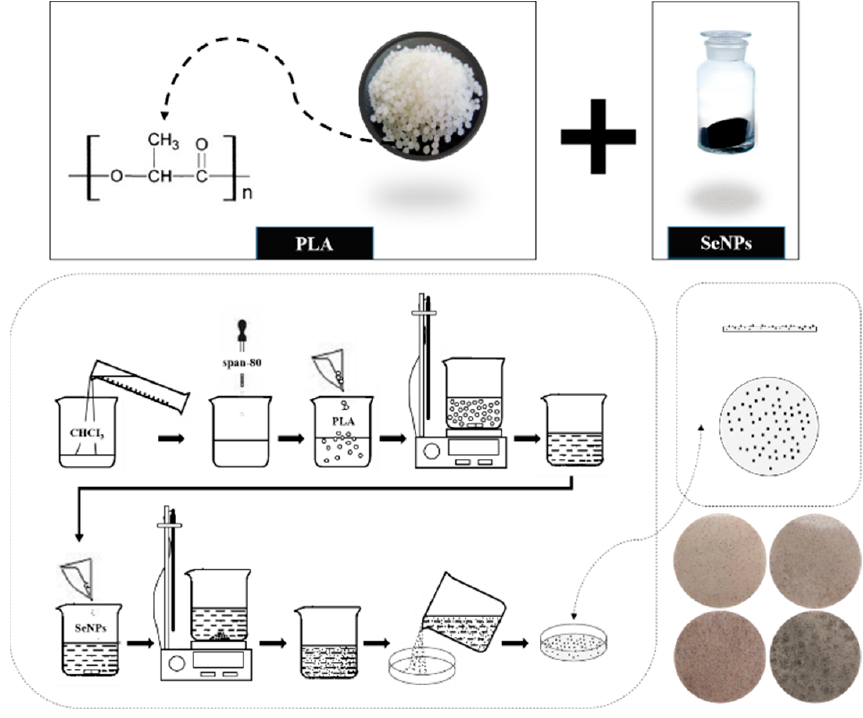
Figure 1. Preparation process of polylactic acid (PLA) and PLA / SeMPs composite films. Table 1. Sample codes and composition for the PLA / SeMPs film-forming solutions.